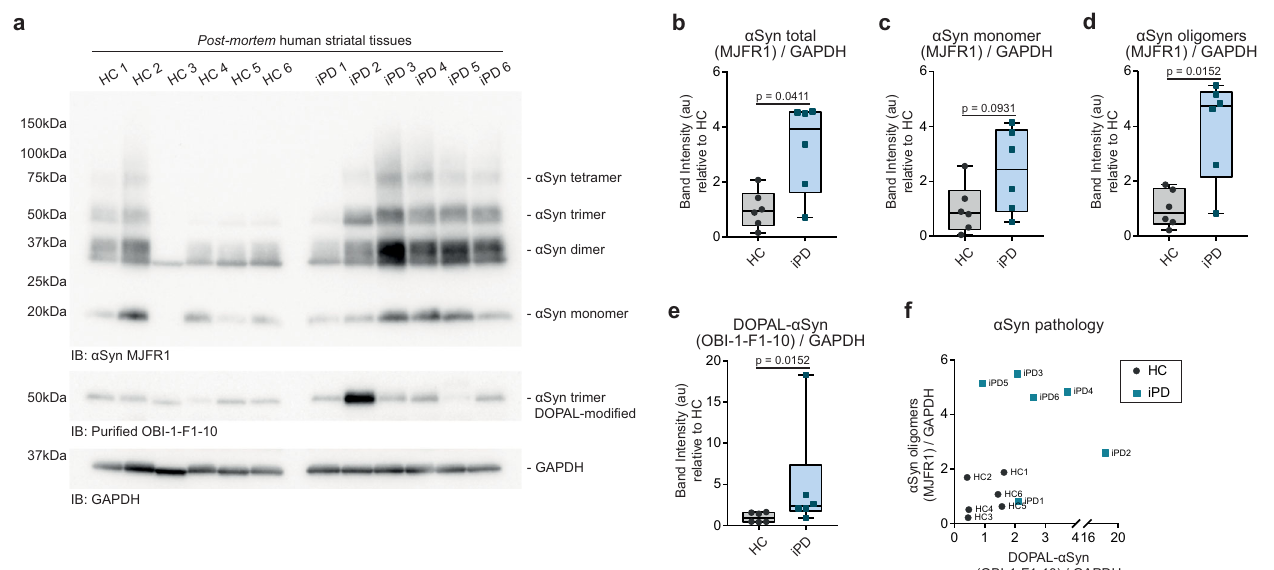
Fig. 9 Detection of DOPAL-modi fi ed α Synuclein in human post-mortem striatal tissues. a Western blot of human post-mortem striatal tissues from six idiopathic PD patients (iPD1-6) and six age-matched healthy controls (HC1-6). The MJFR1 antibody detected monomeric and high-molecular weight oligomeric α Syn species, while the puri fi ed recombinant OBI-1-F1-10 RabMab antibody developed in this study detected DOPAL-modi fi ed α Syn trimers. GAPDH was used as loading control. Relative quanti fi cation of b total α Syn, c monomeric α Syn, d oligomeric α Syn, and e DOPAL-modi fi ed α Syn. Data are normalized to the mean value of healthy controls and analyzed by Mann – Whitney test. Data are displayed as box and whiskers plot showing the minimum and maximum points (whiskers), the fi rst quartile, median and third quartile (box lines). f Correlation of the levels of DOPAL-modi fi ed α Syn (x-axis) and oligomeric α Syn (y-axis) in each